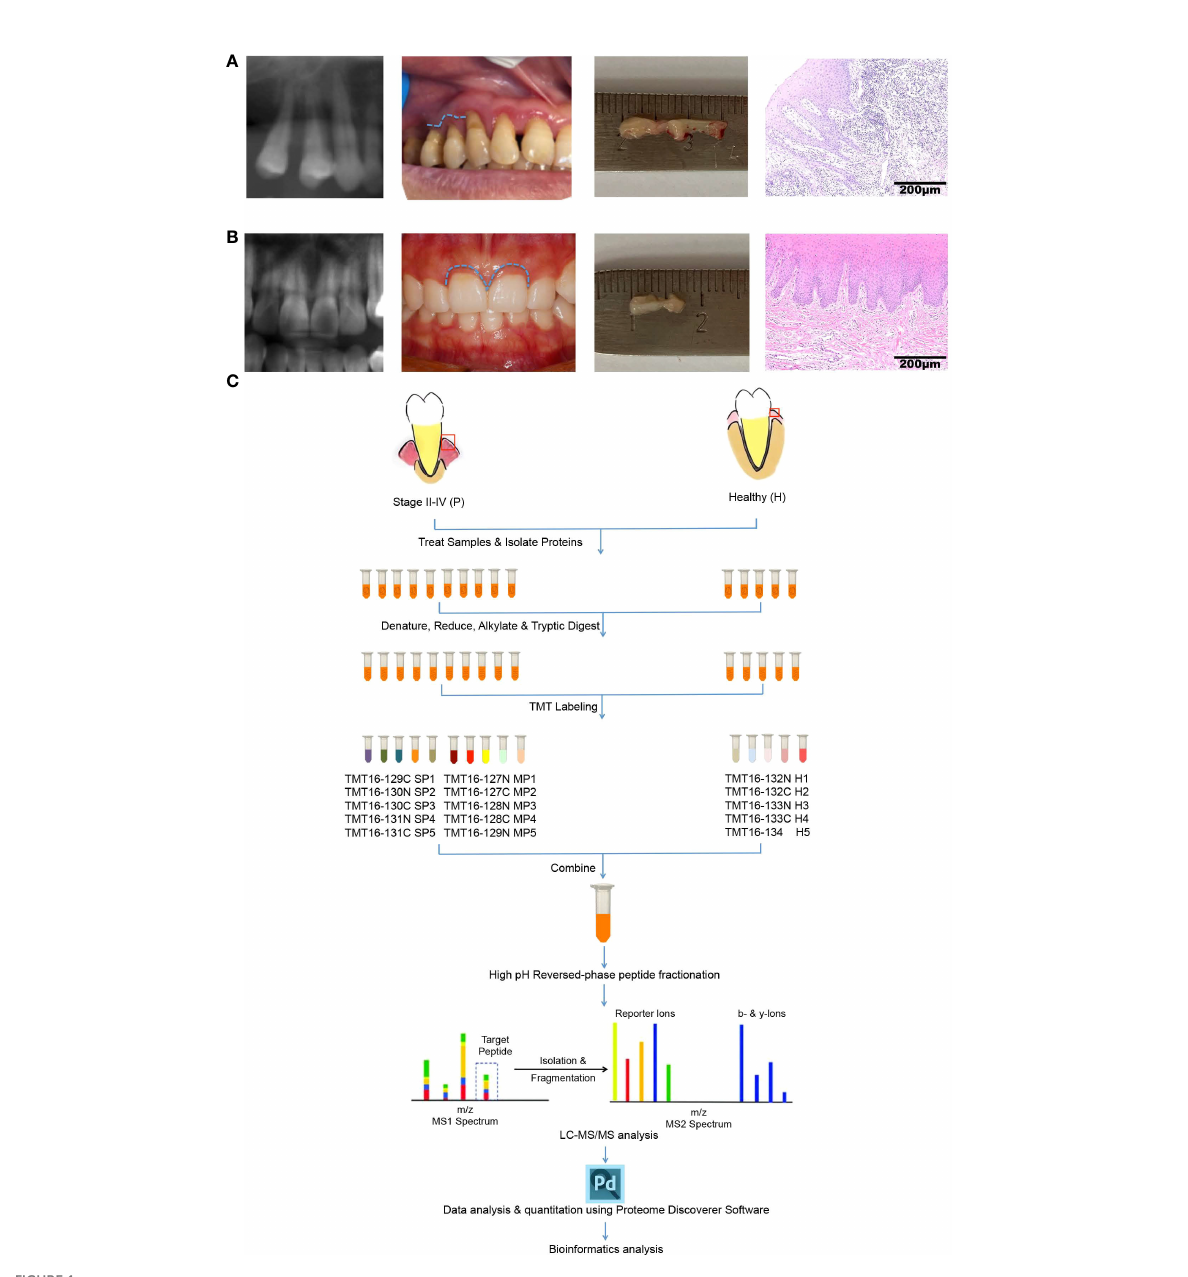
FIGURE 1 Characteristics of gingival tissues from healthy individuals and periodontitis patients and a schematic overview of the quantitative TMT proteomics work fl ow. (A, B) Collection and H&E staining of gingival tissues from healthy individuals (A) and periodontitis patients (B) . (C) Flow diagram of TMT-based quantitative